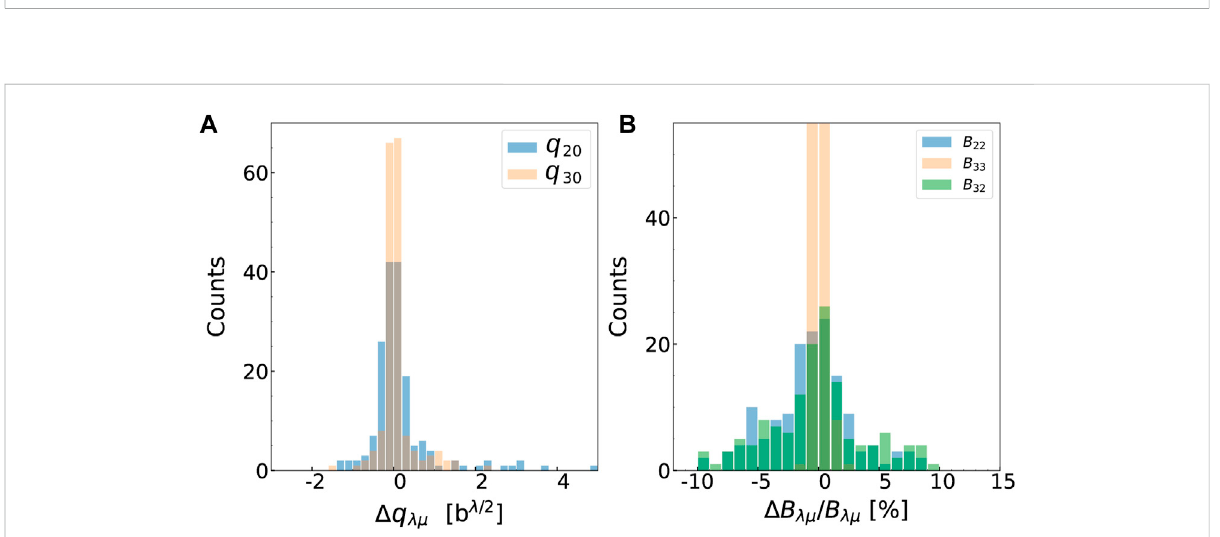
FIGURE 3 (A) :HistogramoftheerrorontheGP-predicted values ofthemultipole moments. Thebinsizeis0.2 b λ /2 with λ =2(quadrupole moment)or λ = 3(octupolemoment). (B) :Histogramoftherelativeerror, inpercents,ontheGP-predictedvalues ofthecomponentsofthecollectiveinertia tensor. The bin size is 1, corresponding to 1% relative